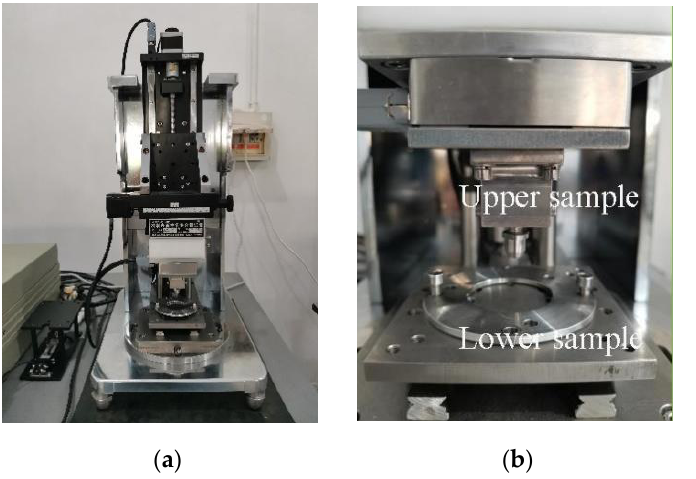
Figure 2. CFT-I type material surface performance comprehensive tester. ( a ) overall picture; ( b ) partial enlarged view.